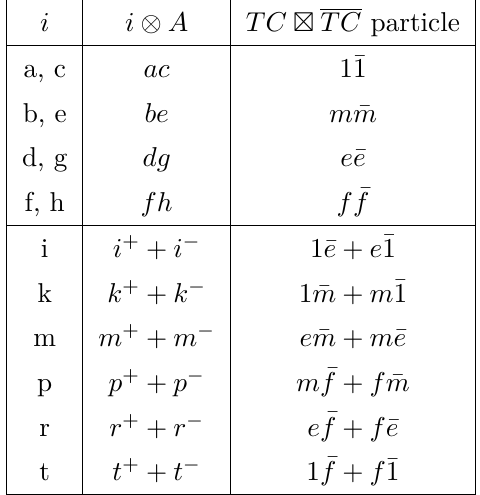
Table 8 . Identify child theory of A = a + c condensation with TC (cid:2) TC .